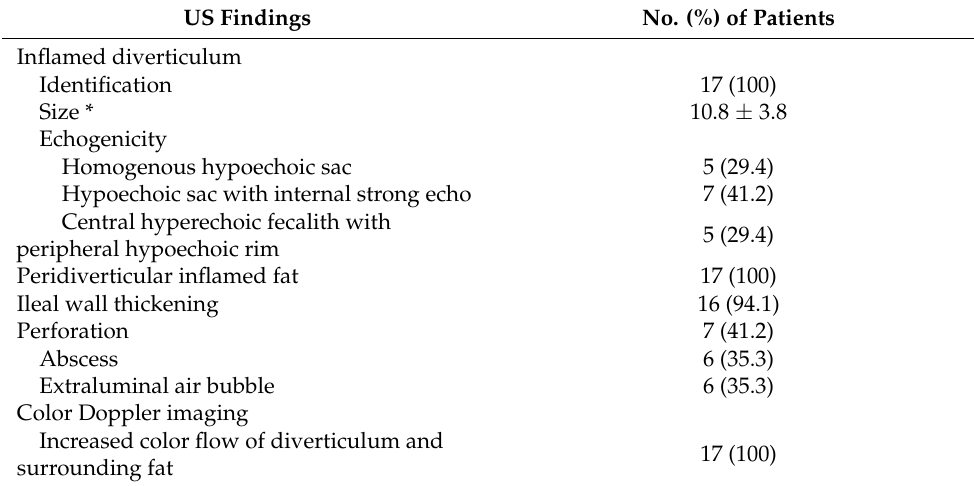
Table 3. US findings for acute ileal diverticulitis. Table 3. US fi ndings for acute ileal diverticulitis.